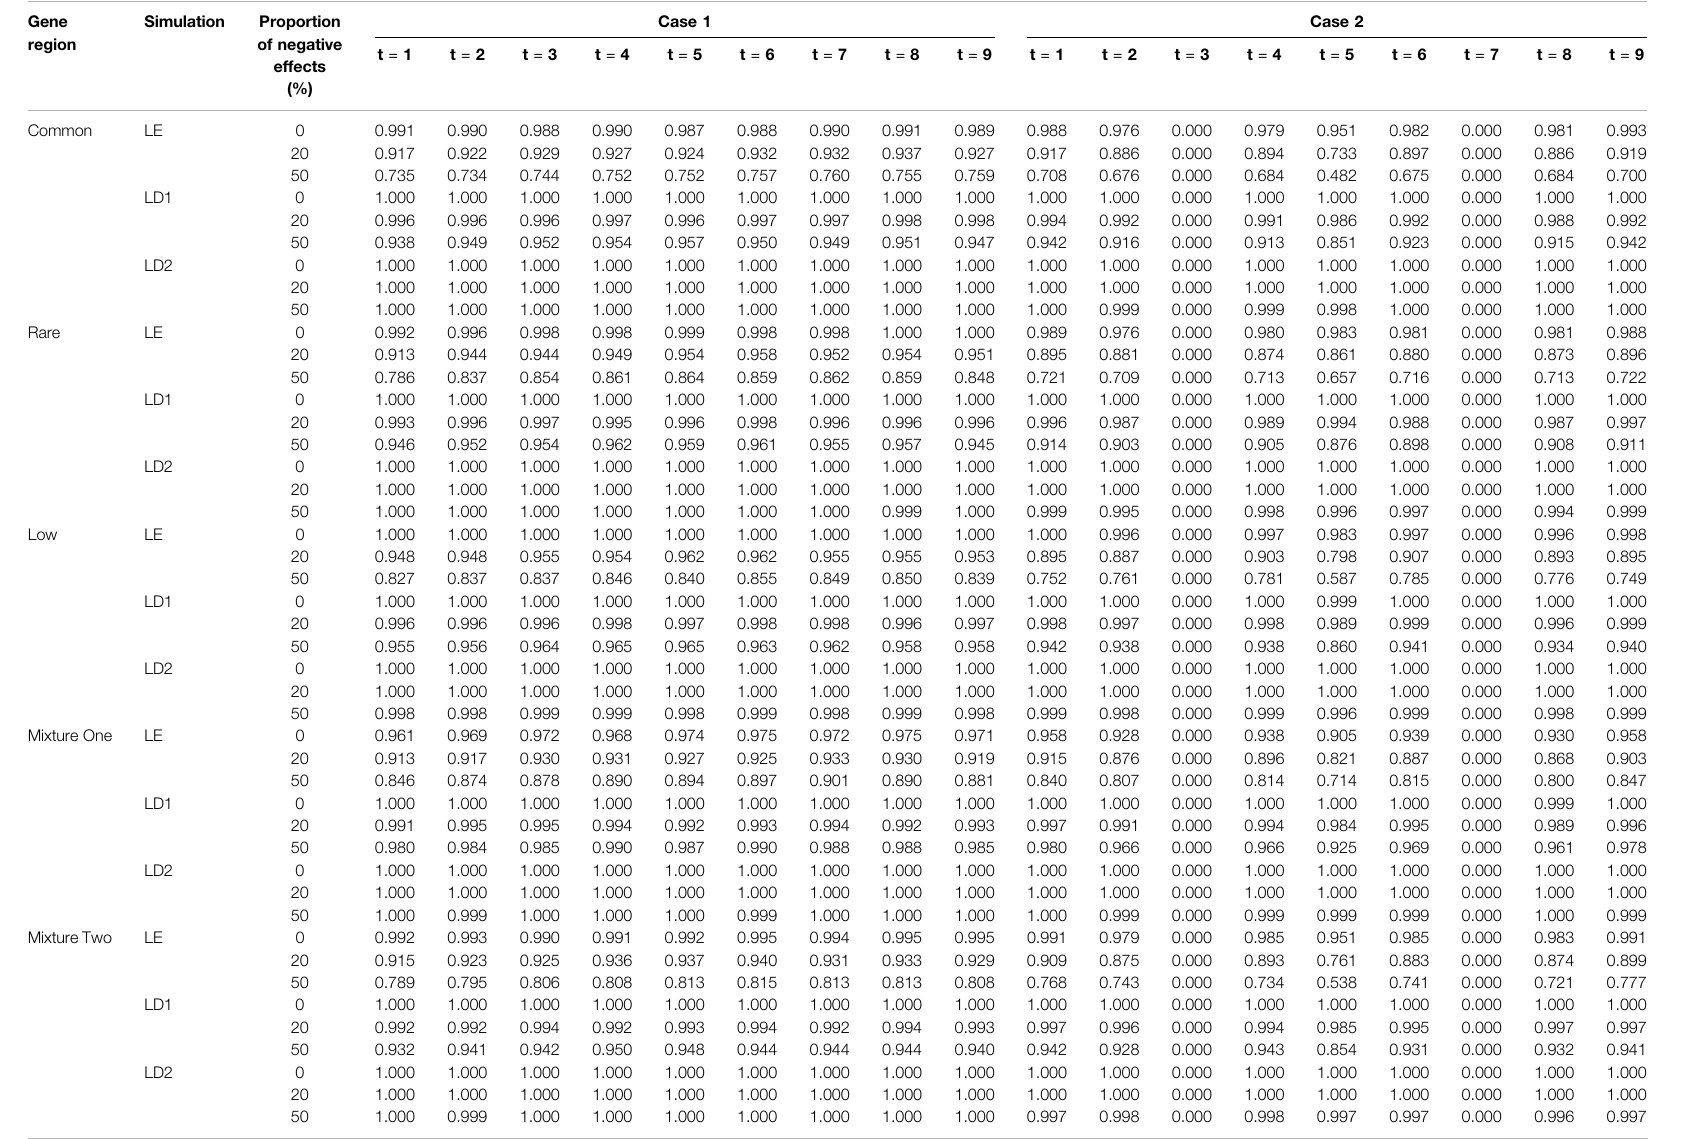
TABLE 8 | Compare the power of linkage equilibrium and linkage disequilibrium simulation based on LFDAT when signi fi cant level is 0.05, sample size is 1,500, c is 5, and proportion of casual variants is 2%. Gene Simulation region